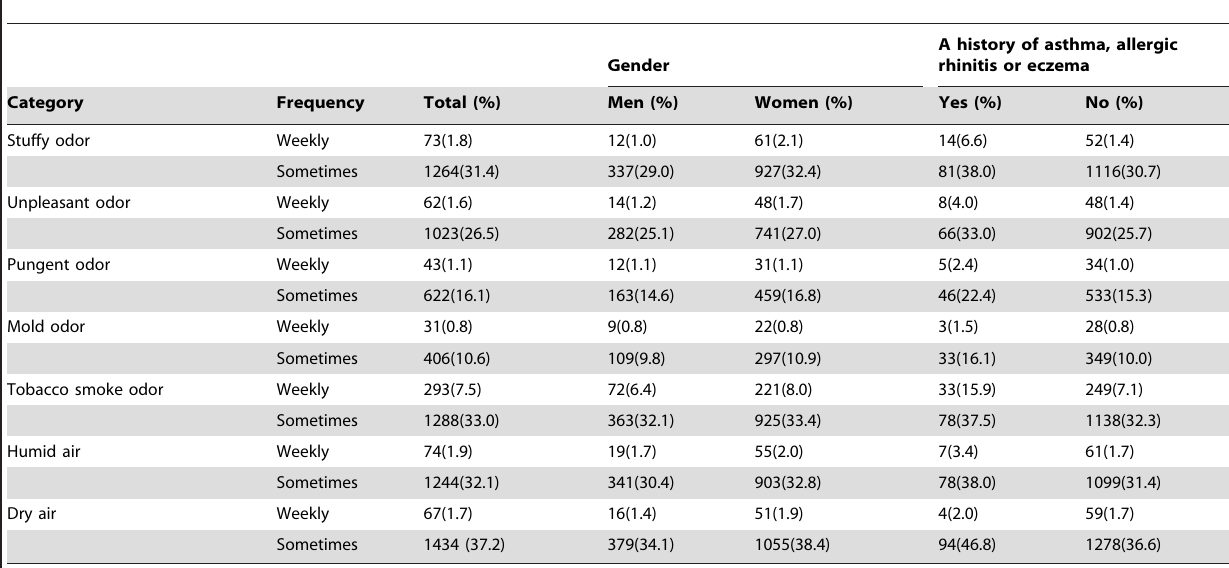
Table 3. Odor and humidity perceptions, stratified for gender and a history of asthma, allergic rhinitis or eczema among parents (n=4530).